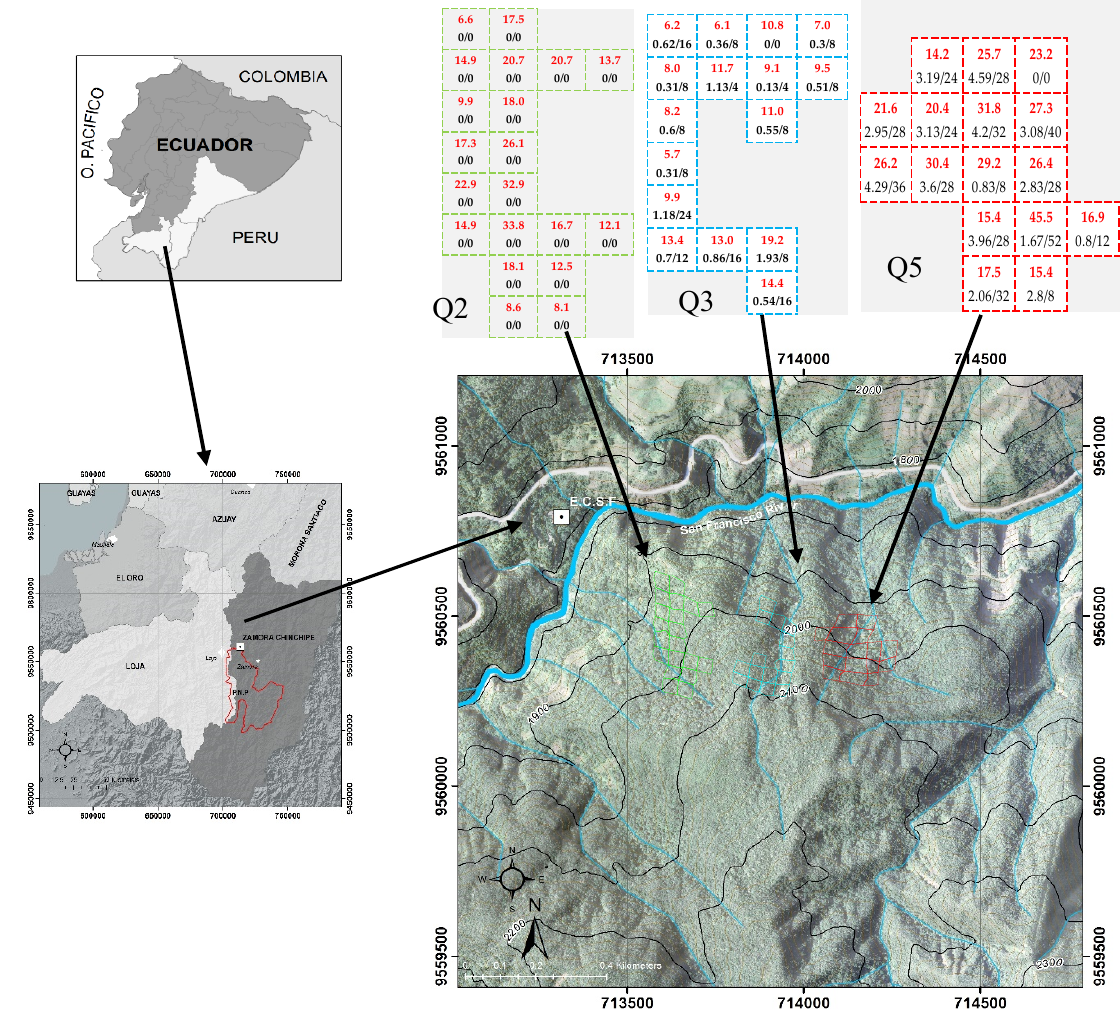
Figure 1. Location of the study area and plot distribution in the RBSF. The red numbers indicate total basal area ha − 1 , other numbers in the squared plots indicate mean values of extracted basal area and the number of extracted trees (basal Area extracted / extracted trees ha − 1 ). All plots in Q2 (green block), as well as the K-plots in Q3 (blue block) and Q5 (red block), are control plots without intervention (i.e., no selective thinning).